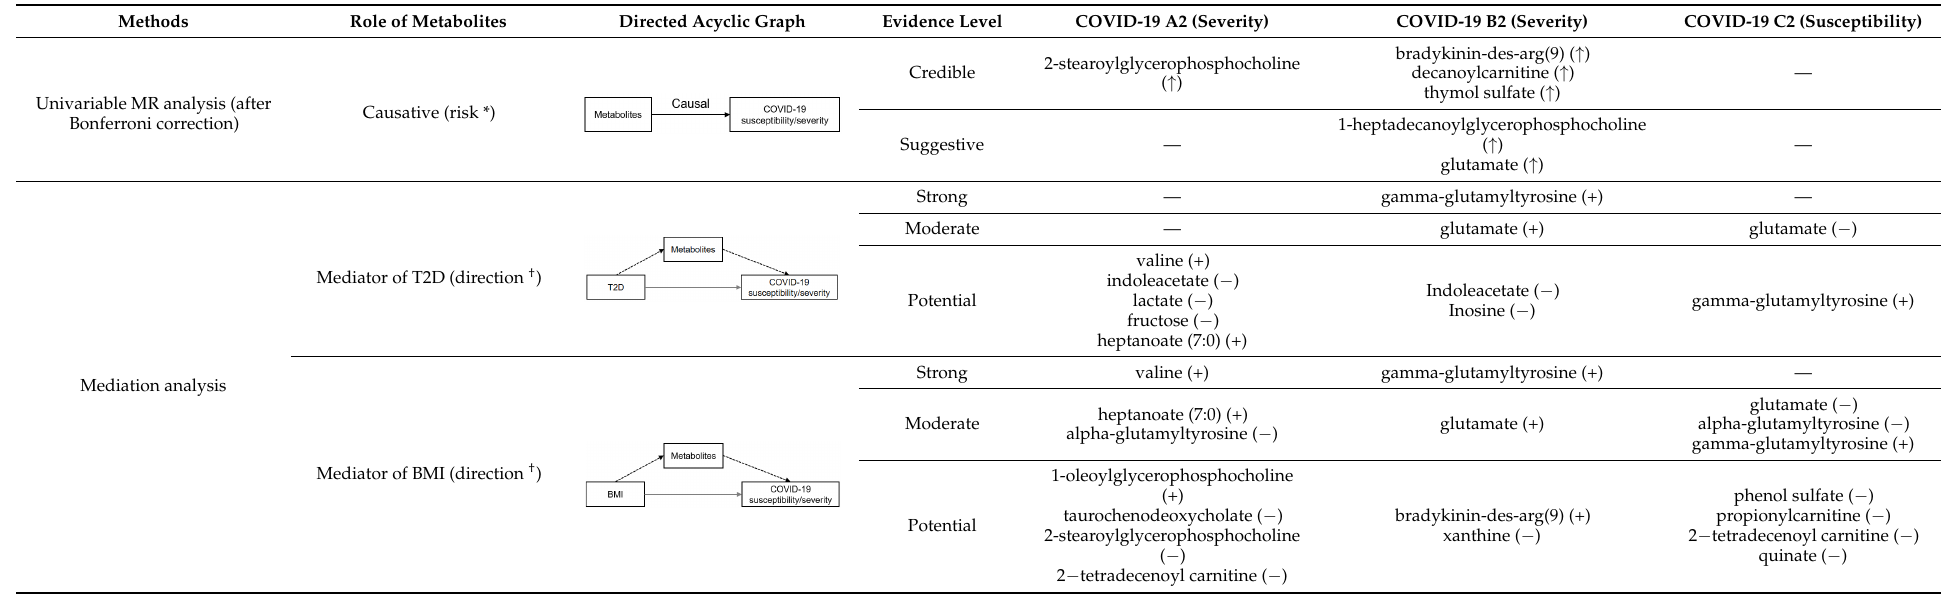
Table 1. Summary of the primary findings in this study.